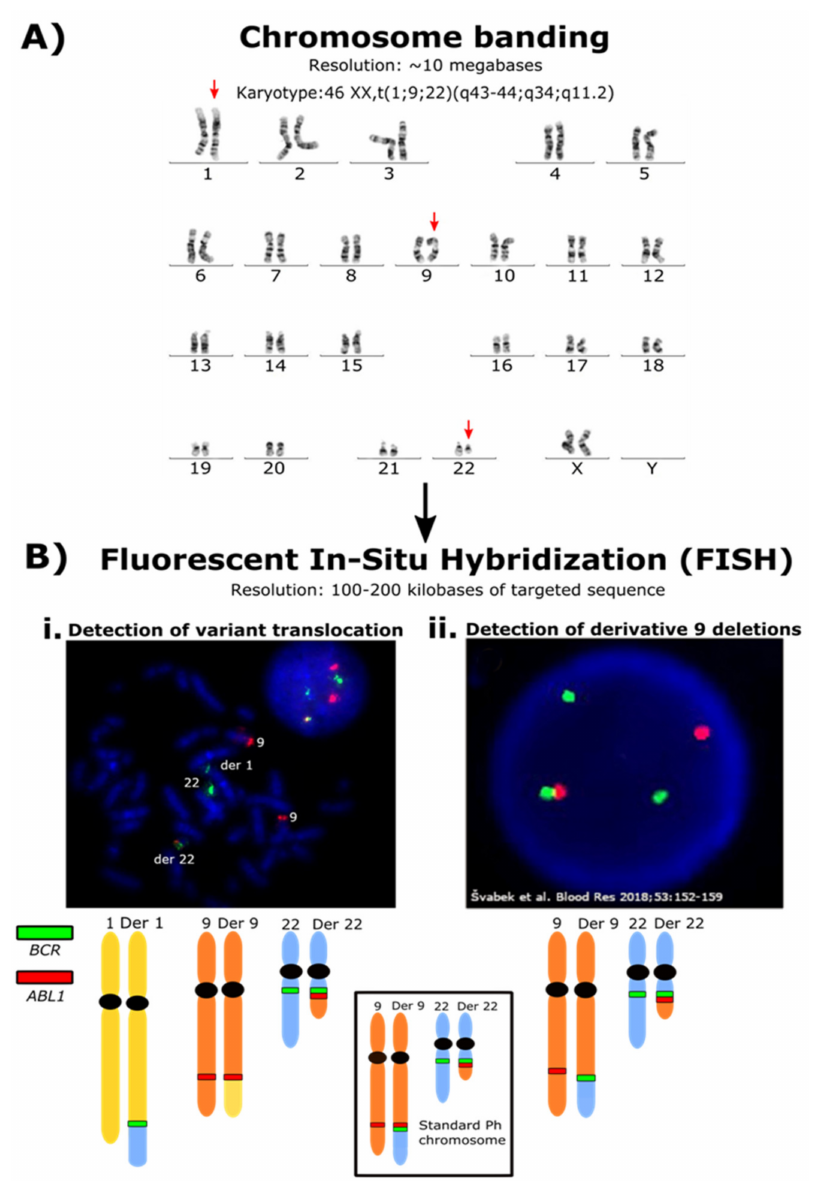
Figure 1. Increasing resolution of techniques for detecting rearrangements associated with the formation of the Ph chromosome. ( A ) Karyotype of a patient with a 3-way variant Ph chromosome. Using chromosome banding, this large-scale chromosomal rearrangement was detectable. The arrows indicate the chromosomes involved in the translocation. The Ph chromosome is the visibly shortened chromosome 22, where the end of the q arm was translocated to chromosome 1. This fragment usually translocates to the derivative chromosome 9. The end of the q arm of chromosome 1 was translocated to the derivative chromosome 9. The resolution of chromosome banding is limited, and the specific genes involved in these rearrangements are undetectable. ( B ) i. FISH analysis using a BCR/ABL dual color dual fusion probe and metaphase spread confirmed the presence of the BCR::ABL1 fusion signal (red and green signal on the derivative (der) 22) but the absence of the reciprocal